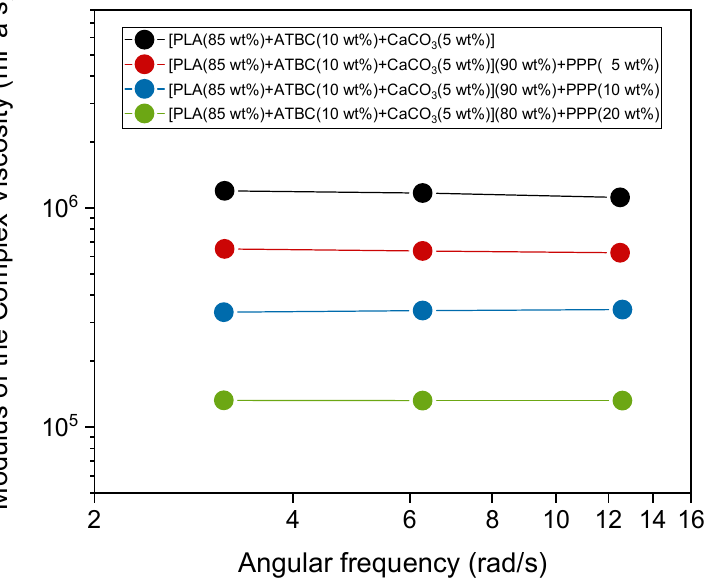
Figure 8. Modulus of the complex viscosity vs. angular frequency at 175 °C for PLA-based matrix and biocomposites indicated in the legend.